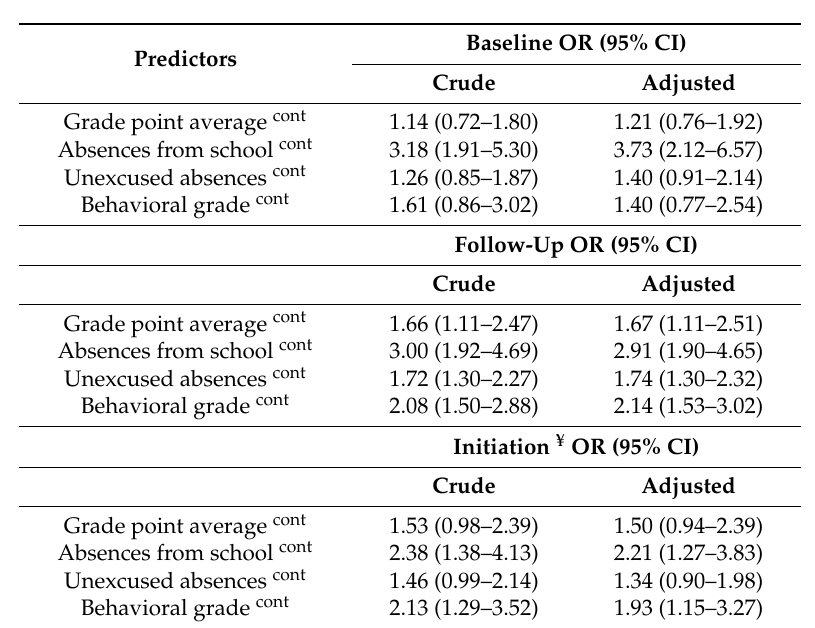
Table 3. Crude and adjusted logistic regression models of the relationship between independent variables and illicit drug misuse at baseline and follow-up, and initiation of illicit drug misuse during the study course, OR with 95% confidence interval